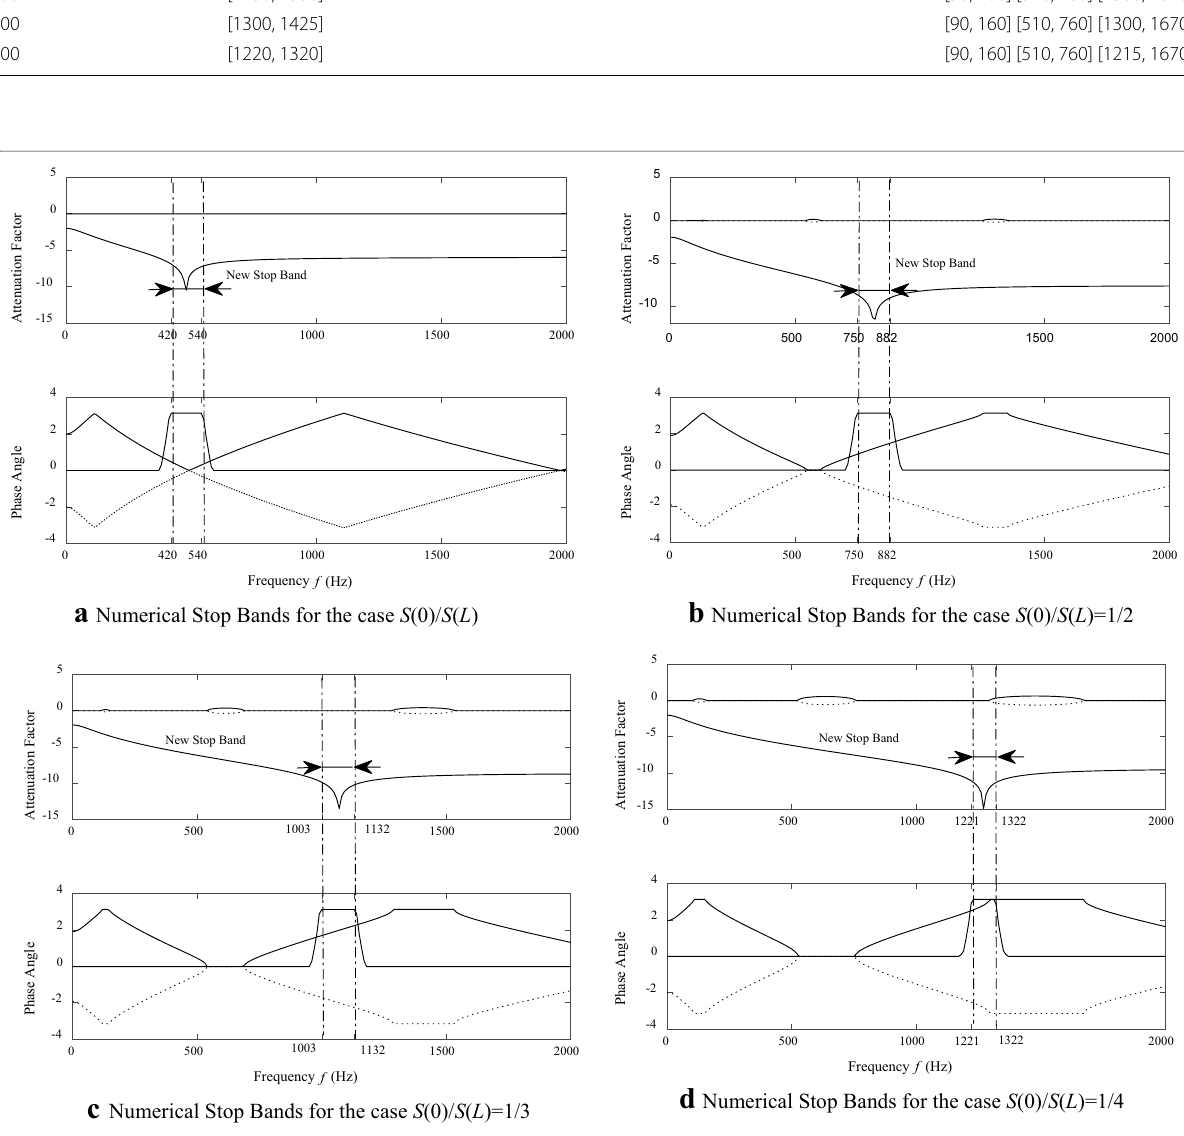
Figure 4 Numerical Propagation characteristics derived at different area